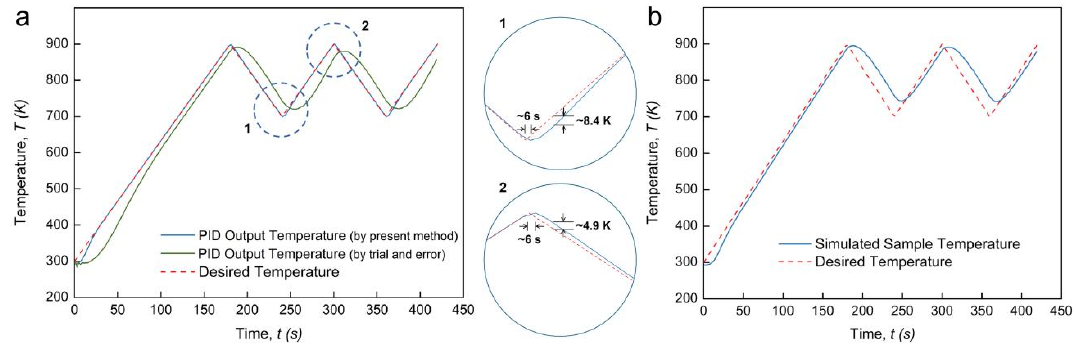
Figure 5. PID regulation outcome for continuous temperature profile: ( a ) PID output temperature profile with enlarged views; ( b ) simulated sample temperature profile.